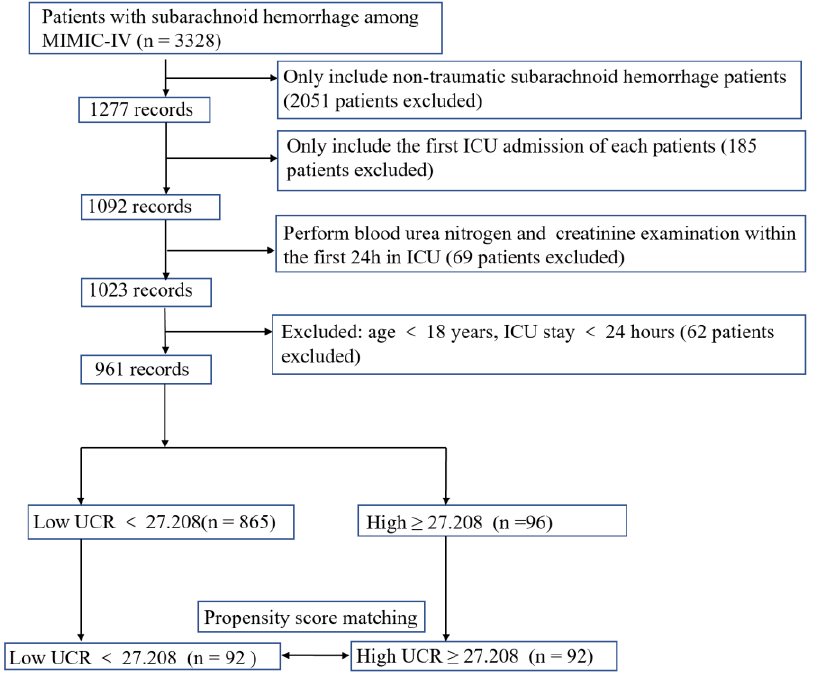
Figure 1. The flow chart of the study. MIMIV-IV, Medical Information Mart for Intensive Care IV; ICU, intensive care unit; UCR, urea nitrogen to creatinine ratio.